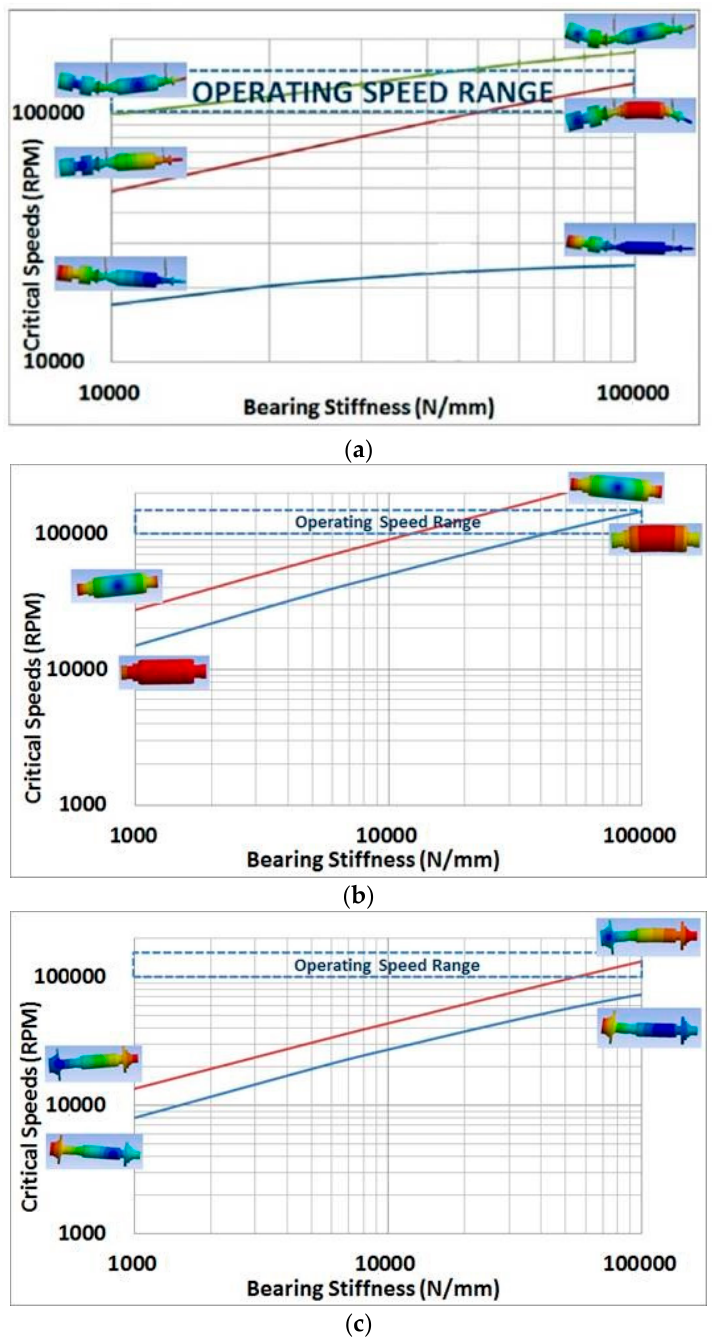
Figure 2. Critical speed maps for three different MGT layouts: ( a ) cantilever turbine and compressor, ( b ) two coupled shafts for turbocomponents and HSG ( c ) HSG between turbine and compressor. Table 1. MGT components material properties.